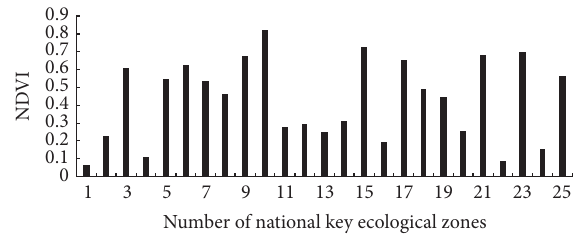
Figure 4: Mean values of NDVI in NKEFZ (the number can refer to Figure